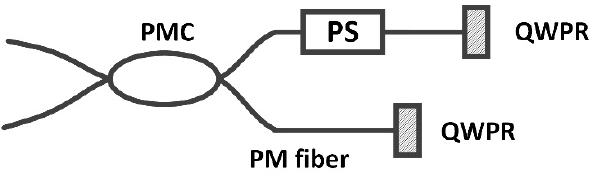
Figure 1. Unbalanced-arm Michelson interferometer with two quarter-wave plate reflectors (QWPRs) as mirrors, a polarization maintaining coupler (PMC), a phase shifter (PS), and PM optical fibers.